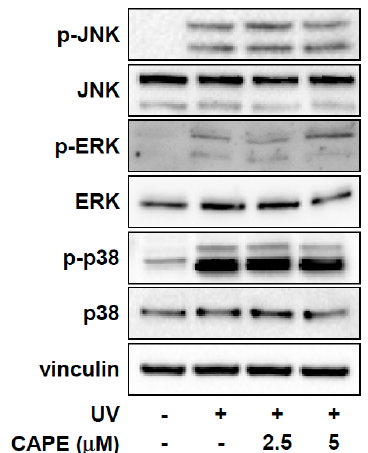
Figure 4. Effect of CAPE on UV-induced MAPK signal pathway in HDF cells. Cells were pre-treated with CAPE for 1 h before being exposed to UV. After harvesting the cells, phosphorylation and total protein expression of the MAPK signaling pathways were determined by immunoblot analysis.